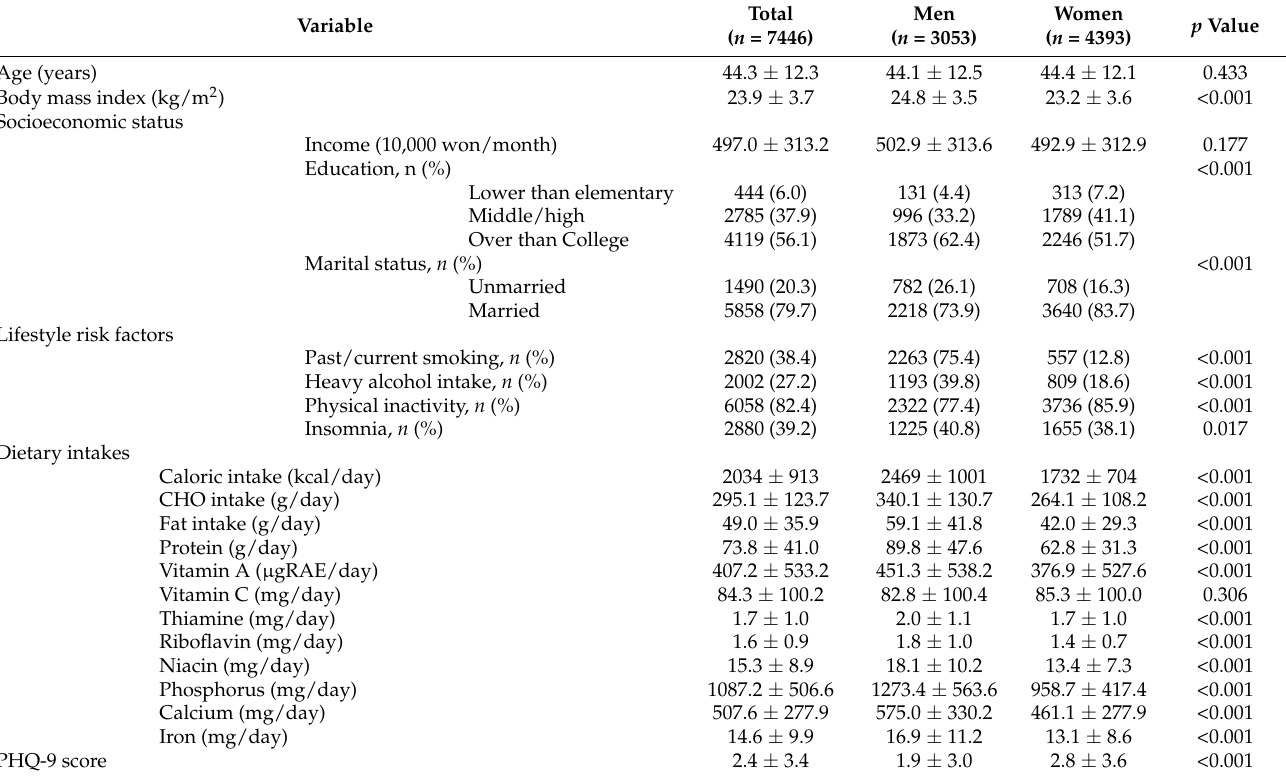
Table 1. Characteristics of study